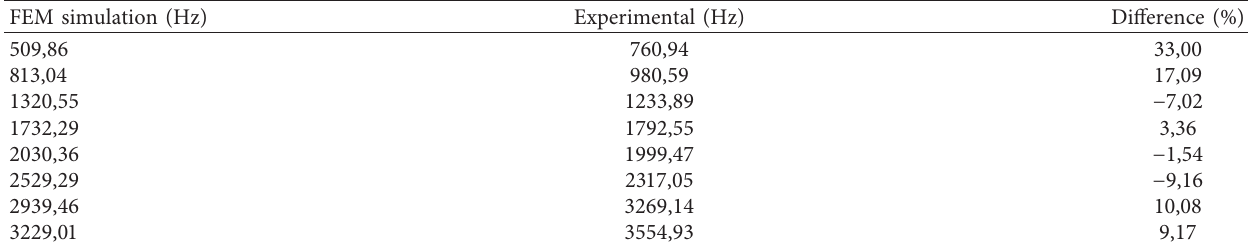
Table 14: Comparison of numerical and experimental frequencies (Case 3).